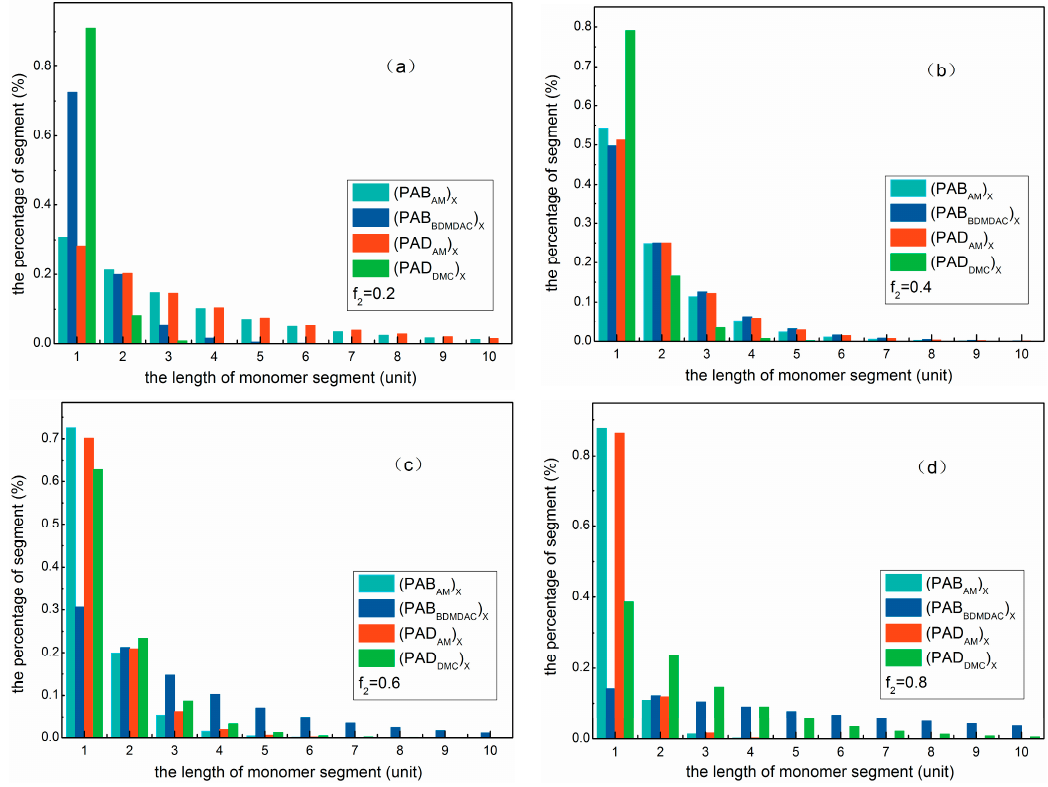
Figure 3. Sequence distributions of cationic monomer and acrylamide (AM) in the polymers under ( a ) f 2 = 0.2; ( b ) f 2 = 0.4; ( c ) f 2 = 0.6; and ( d ) f 2 = 0.8.